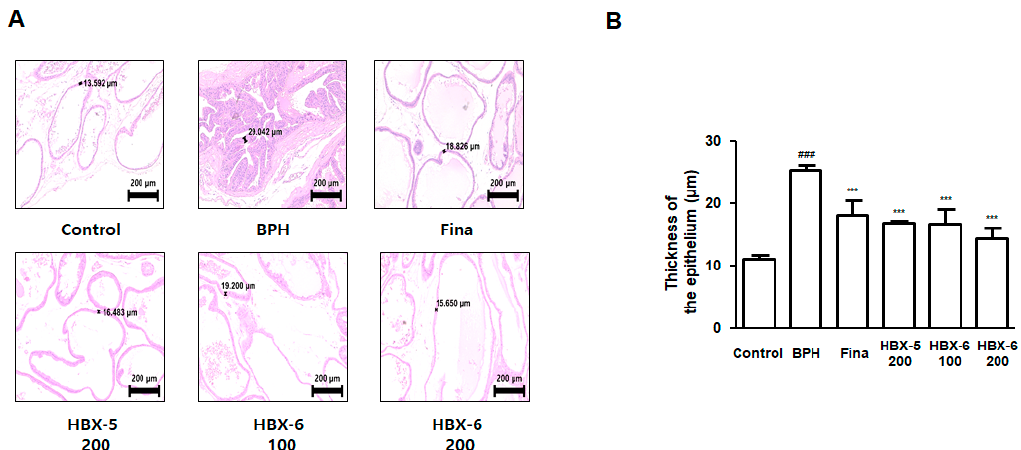
Figure 6. Effect of HBX-5 on the prostatic cell proliferation. ( A ) Prostatic tissue section from mice with BPH was stained with H&E; original magnification 100 × . ( B ) Thickness of prostatic epithelial tissue. TETP was measured and represented as the mean ± SD ( n = 5 for all experimental group). TETP was quantified at three section per each slide; ### p < 0.001 versus control group; *** p < 0.001 versus BPH group. ANOVA and Dunnett’s post hoc test were used for significances between each experimental group.